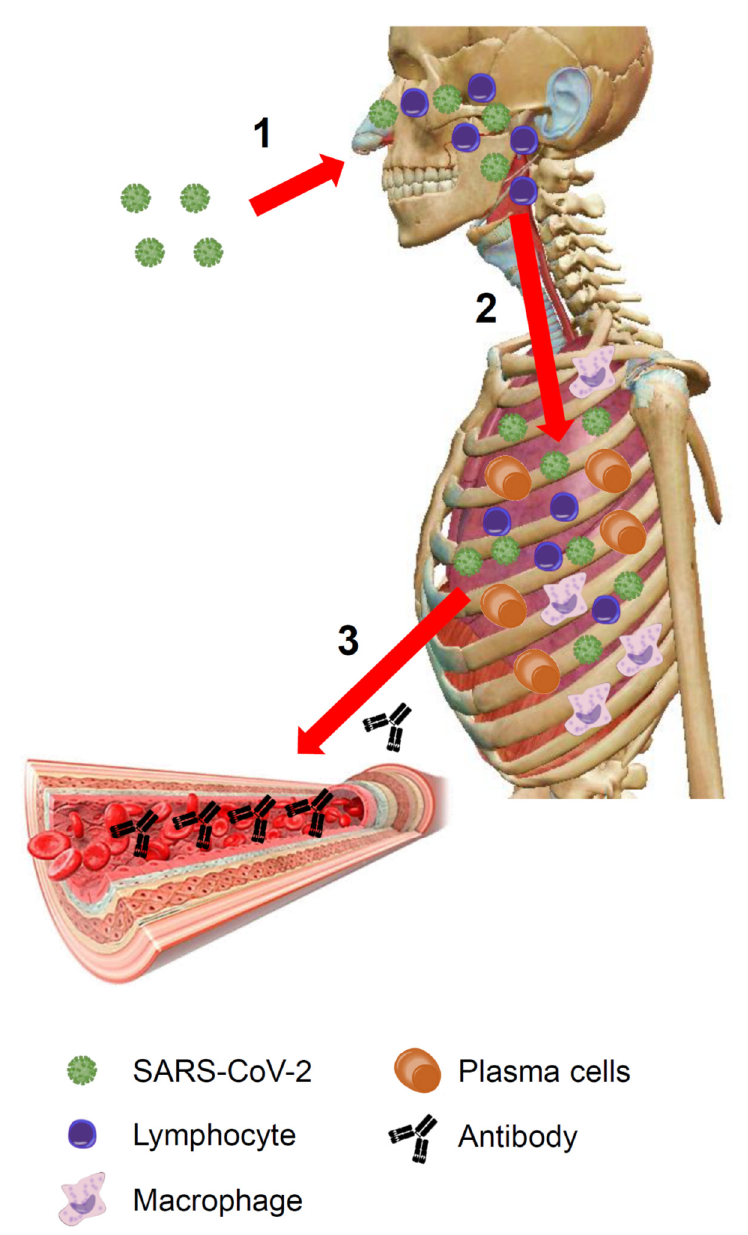
Figure 1. COVID-19: an overview. ( 1 ) The virus enters the body through the upper respiratory tract and invades the respiratory mucosa covering the nasal cavities, the paranasal sinuses, and the nasopharynx. Here it replicates and encounters immune cells. The immune system, via the Waldeyer’s ring, recognizes viral antigens activating innate immunity. ( 2 ) If the virus is not eradicated at this stage, it reaches the lower airways and enters the bloodstream through the respiratory barrier. The architecture of the primary pulmonary lobules is rapidly subverted by the violent inflammatory response, including both innate and adaptive immune-systems activation (lymphocytes, macrophages, plasma cells, etc.). ( 3 ) Plasma cells produce antibodies that by the bloodstream (the lung is a highly vascularized organ) can travel throughout the body. (The image of the human body is a courtesy of Visible Body Atlas.). SARS-CoV-2: severe acute respiratory syndrome coronavirus 2.